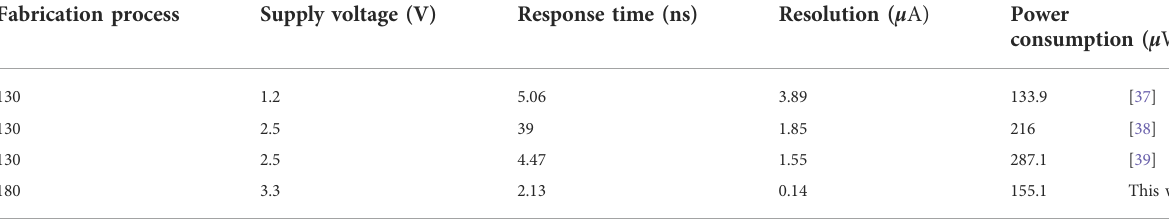
TABLE 1 Performance comparison between the proposed ASC and other MAX selection